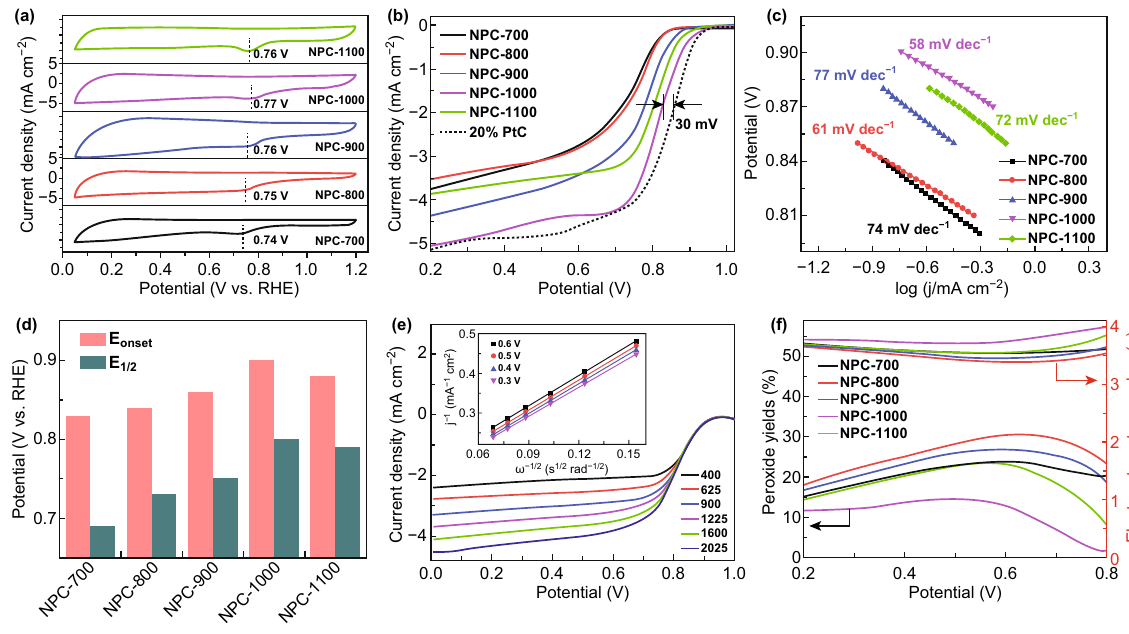
Fig. 4 a Cyclic voltammograms (CVs), b ORR polarization curves (sweep rate: 10 mV s −1 ; rotation speed: 1600 rpm) of the as-prepared cata- lysts in an O 2 -saturated 0.1-M KOH electrolyte, c Tafel plots derived from b , d comparison of the onset ( E onset ) and half-wave ( E 1/2 ) potentials of different catalysts, e LSV curves of NPC-1000 at different rotation speeds (insert shows the corresponding Koutecky–Levich plots), f